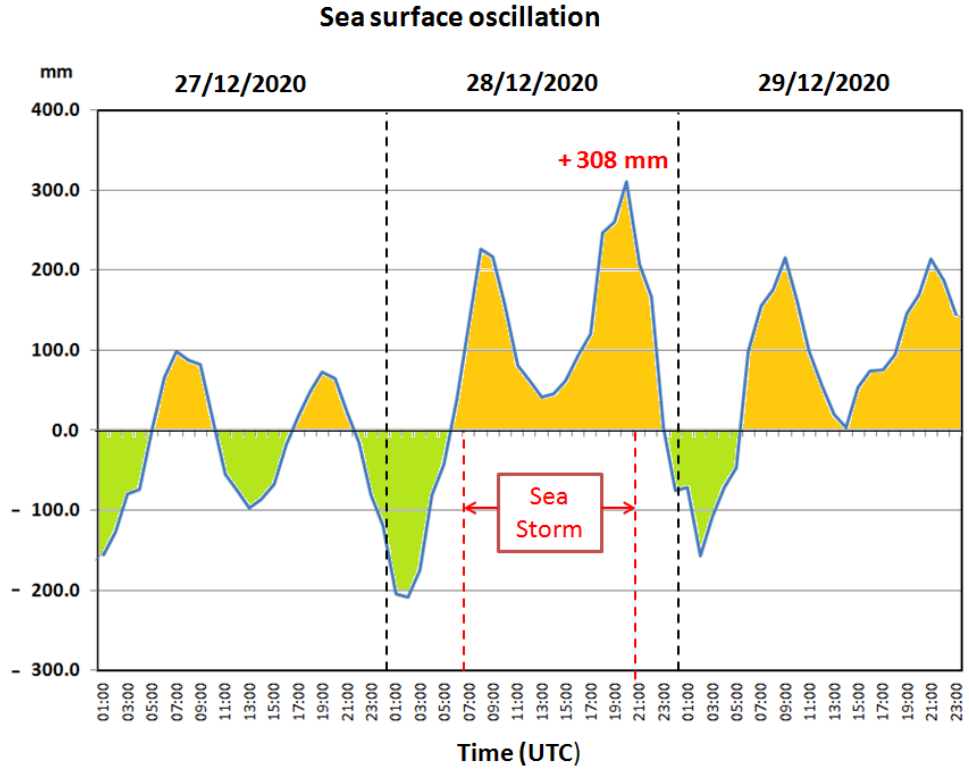
Figure 16. Sea surface oscillation in the Gulf of Naples on 27–29 December 2020 (Time: UTC). The diagram shows the stormy phase.